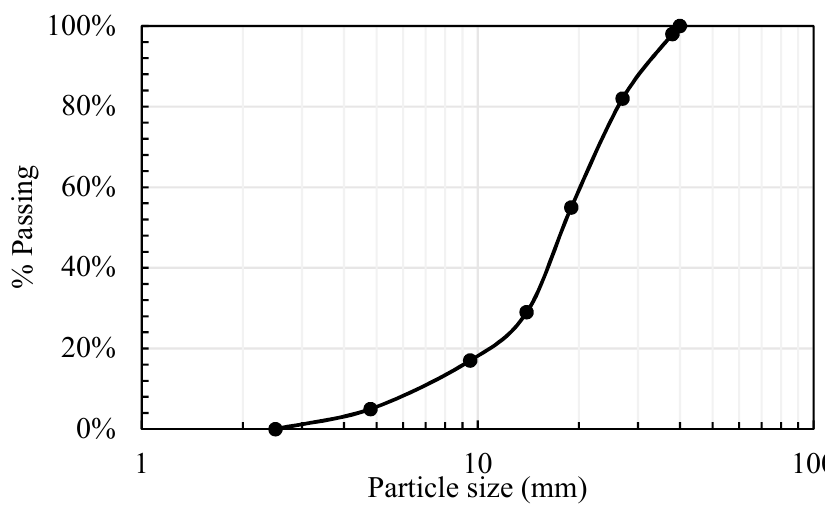
Figure 5. Particle size distribution used in the experiments (adapted from [30]). After the system has reached equilibrium, normal stress is applied at the top and bottom of the assembly (see Figure 6a) and kept constant by adjusting the velocity of the top and bottom plates, utilizing the servo-control feature in PFC. The lower section of the box is then moved horizontally under a constant rate to apply the shear force on the ballast assembly [31]. A slow rate of shearing of 0.4 mm/s is used throughout the analysis. This rate was chosen by comparing the shear stress–strain results for different shear rates (from 0.04 mm/s to 40 mm/s) to avoid unduly sample disturbance during shear [3,27,32] and to save on computational time. At 40 mm shear displacement, the assembly would reach a maximum shear strain of about ε s = 13.3%.